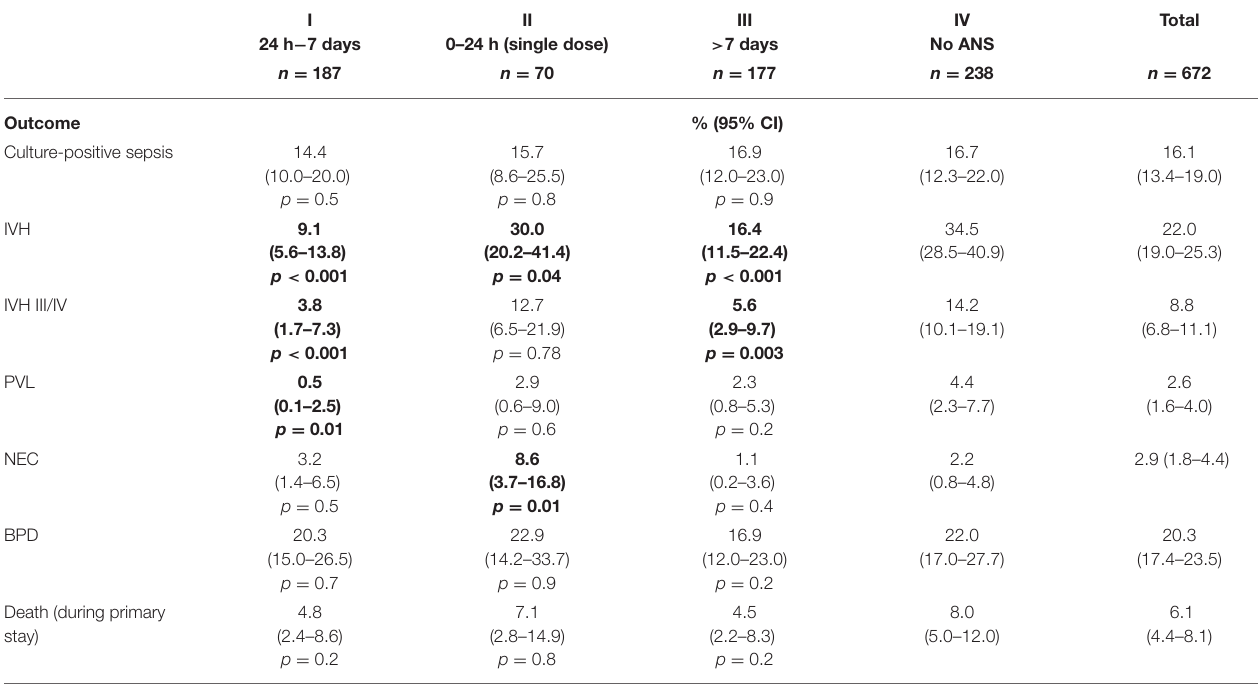
TABLE 4 | Neonatal outcomes stratified to ANS stratified by ANS timing group.